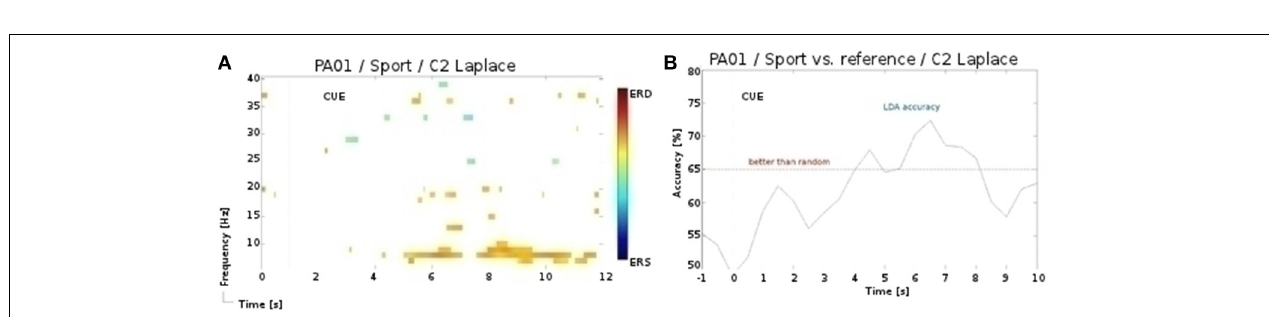
FIGURE 4 | ERD/S map for the participant P1 and for the sport, and the attempted feet task of the 1st session, calculated for Laplacian channel derivations. Marked with the red circle is the Laplacian channel derivation yielding the highest accuracy, as estimated with the blockwise nested crossvalidation.